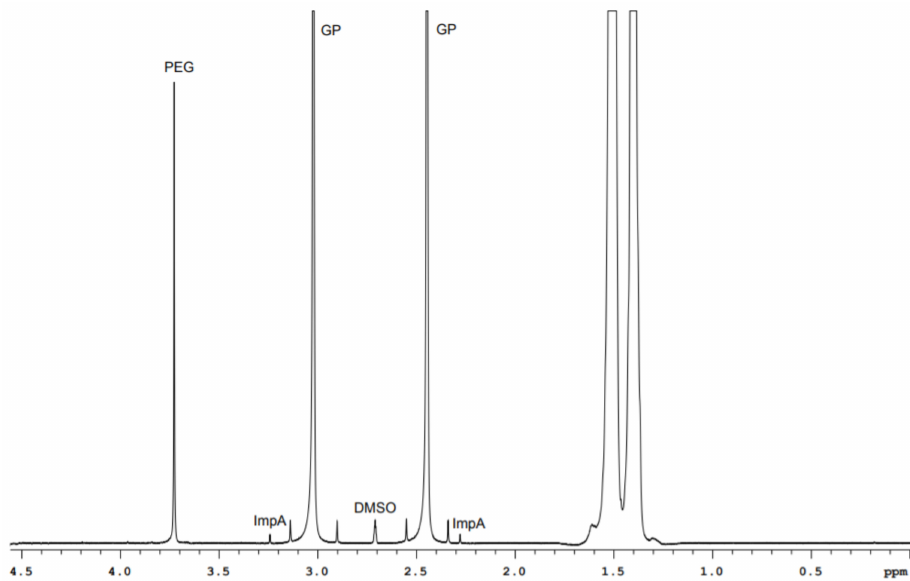
Figure 3. 1 H spectrum fragment of GP drug (capsules I).